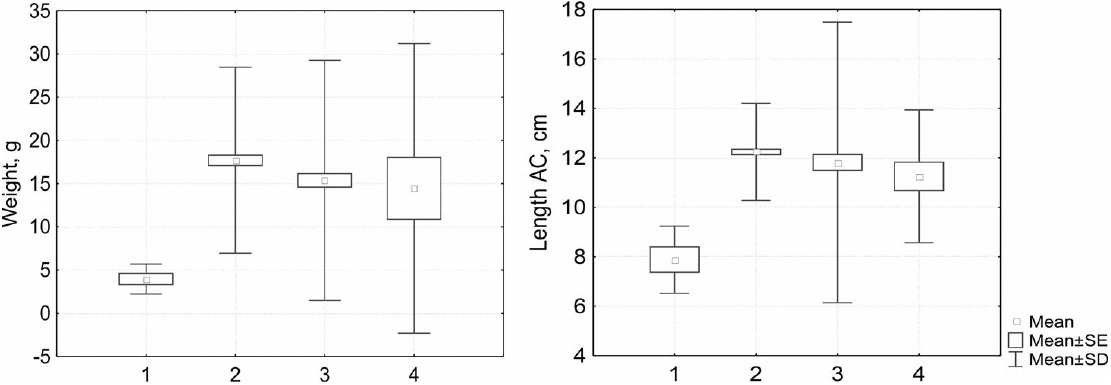
Figure 3. Comparative size-and-weight parameters of vendace in Lake Nyudjavr and di ff erent parts of Lake Imandra (1: Nyudjavr; 2: Bolshaya Imandra; 3: Jokostrovskaya Imandra; 4: Babinskaya Imandra).